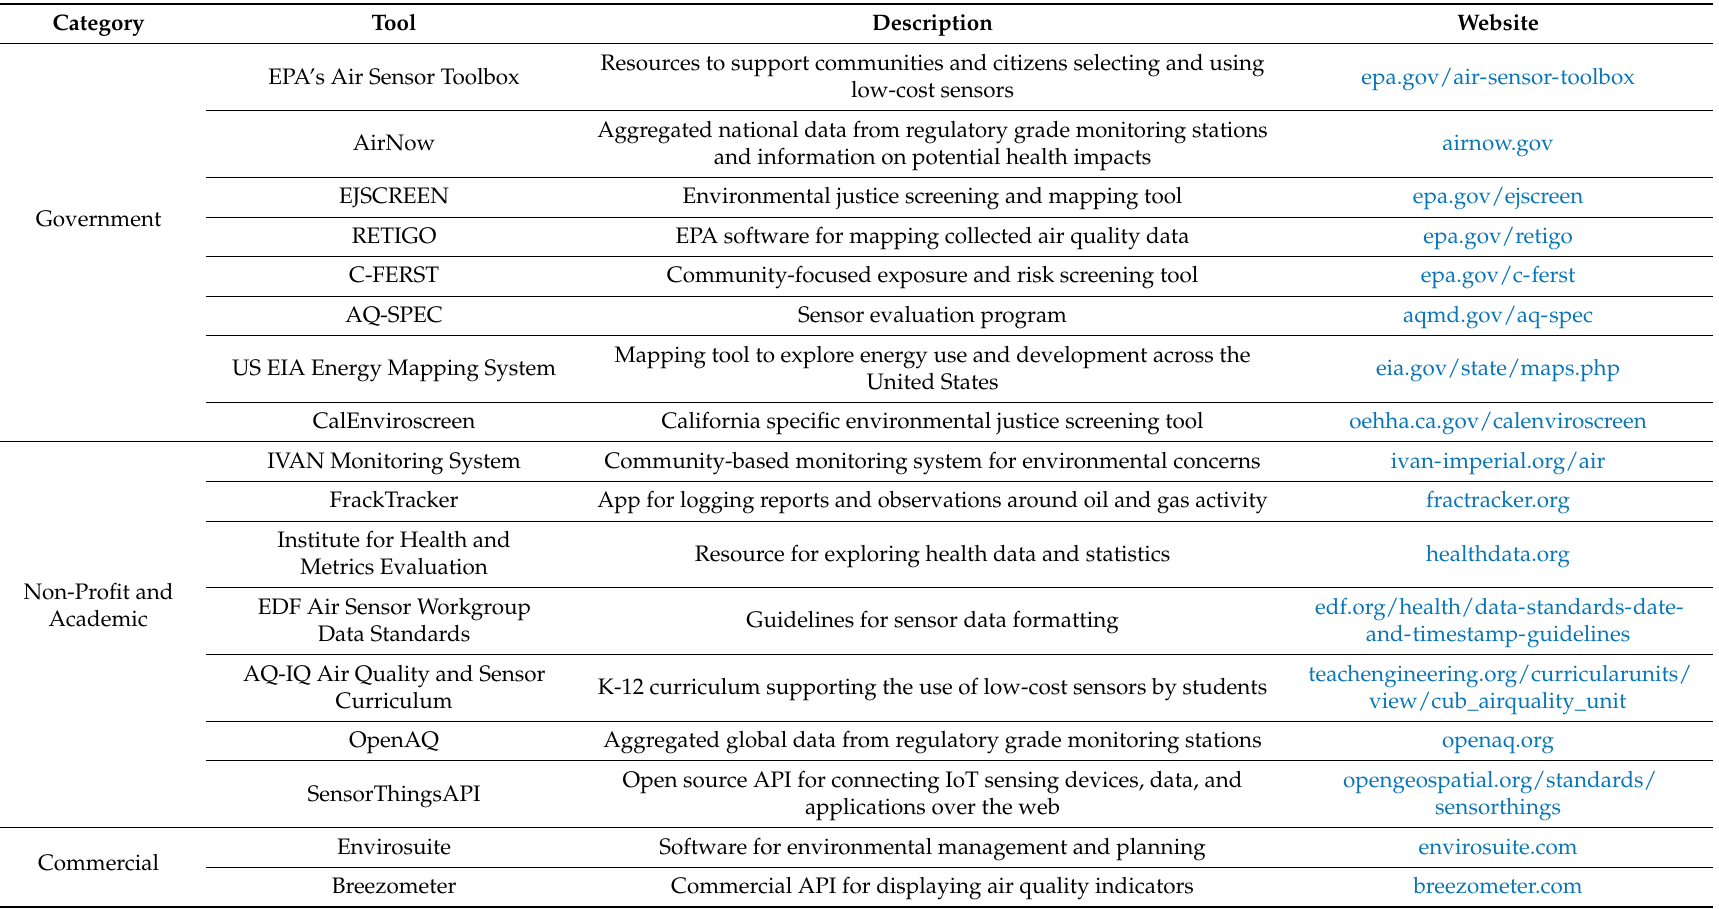
Table 1. Online tools that may be useful to low-cost air quality research